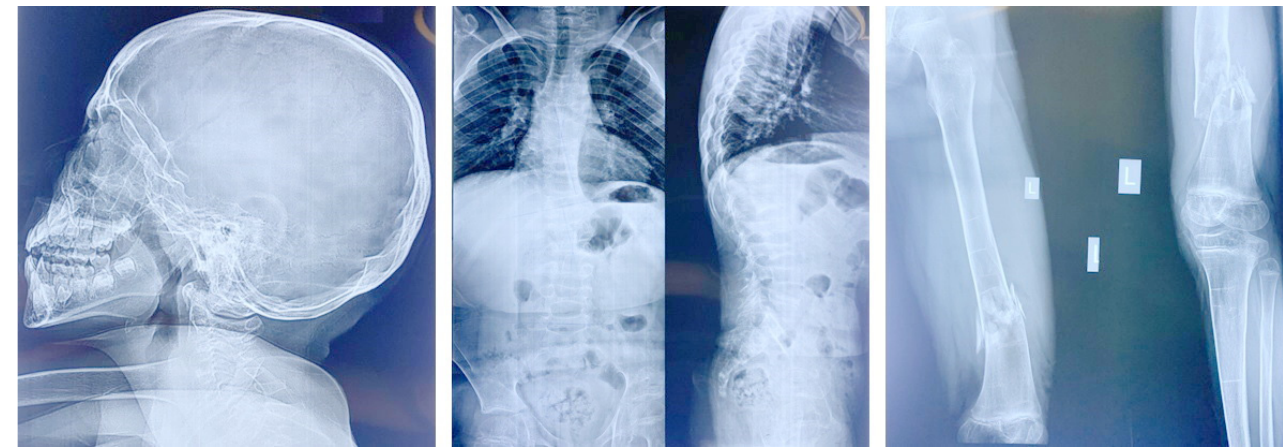
Figure 2. X-rays of patient 1 showing thinning of the occipital bone, abnormal vertebrae, kyphosco- liosis, femoral fractures, and bone demineralization. iosis, femoral fractures, and bone